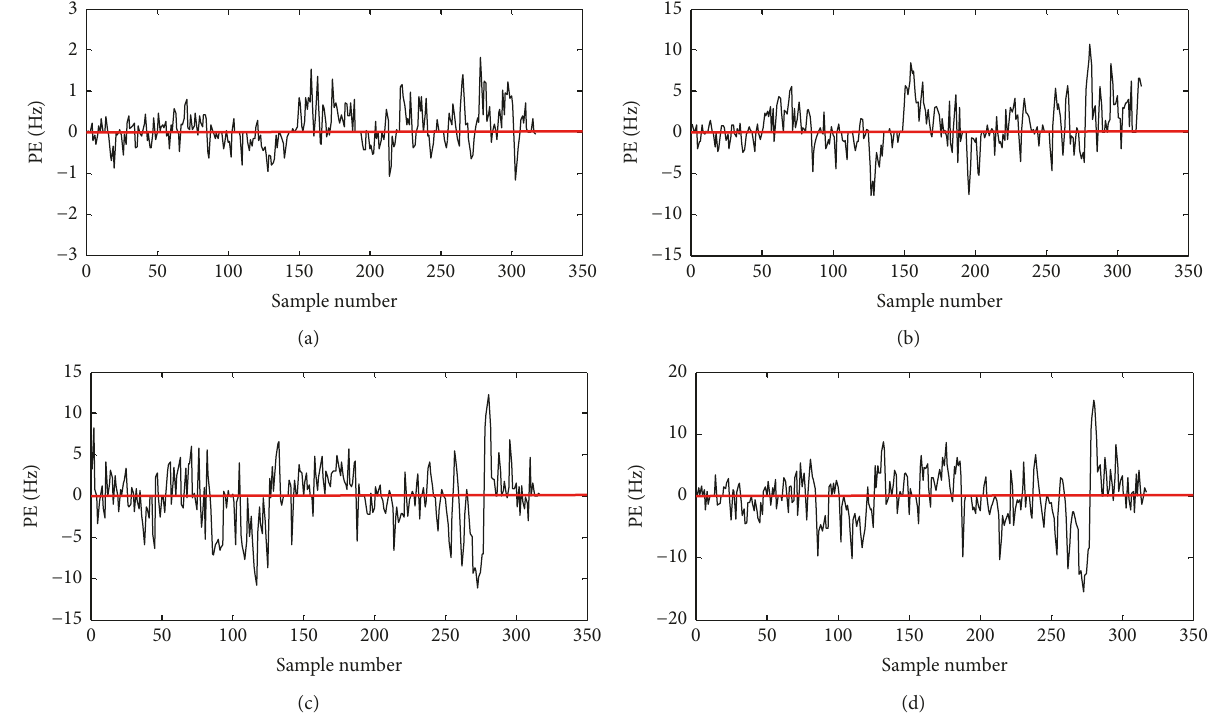
Figure 10: PEs of first four modal frequencies by use of SVR model. (a) 1st mode; (b) 2nd mode; (c) 3rd mode; (d) 4th mode.